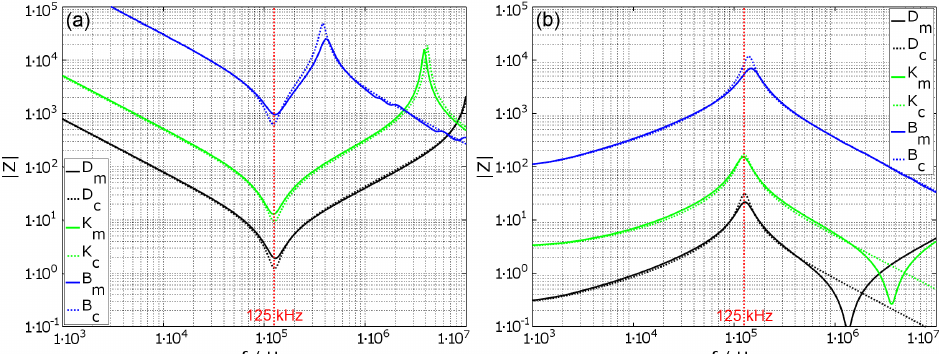
Figure 4. Comparison of the calculated (- -) and measured (–) absolute impedance frequency response for serial ( a ) and parallel ( b ) tuned coils to 125kHz. The different parameters of the coils ’B’, ’D’, = 0.1mm, N = ’K’ are N B = 200, D W B (cid:31)